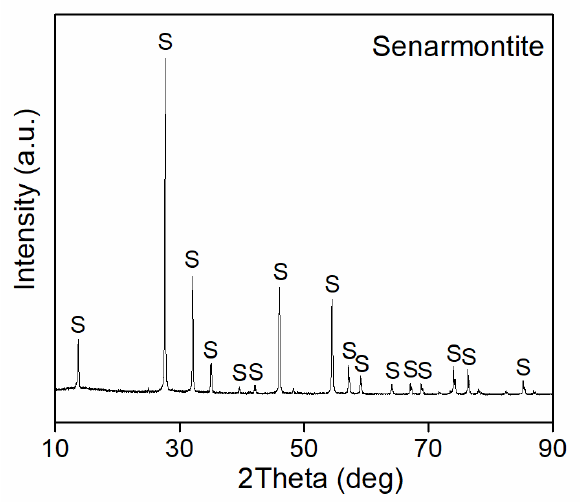
Figure A7. XRD result for alumina PA. Corundum (O) was identified.